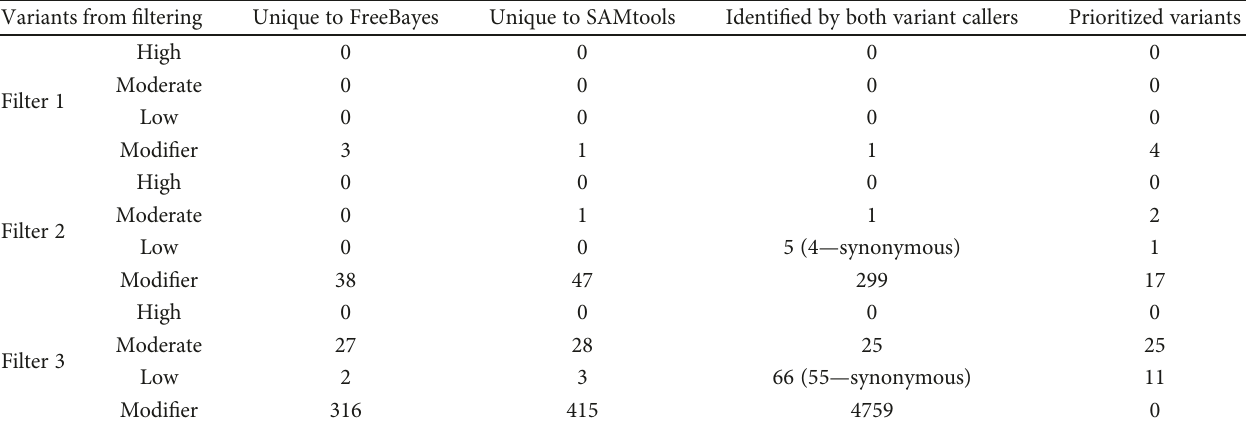
Table 2: Number of variants identi fi ed and prioritized for further evaluation based on three fi ltering parameters and mapping to EquCab2. Variants from fi ltering Unique to FreeBayes Unique to SAMtools Identi fi ed by both variant